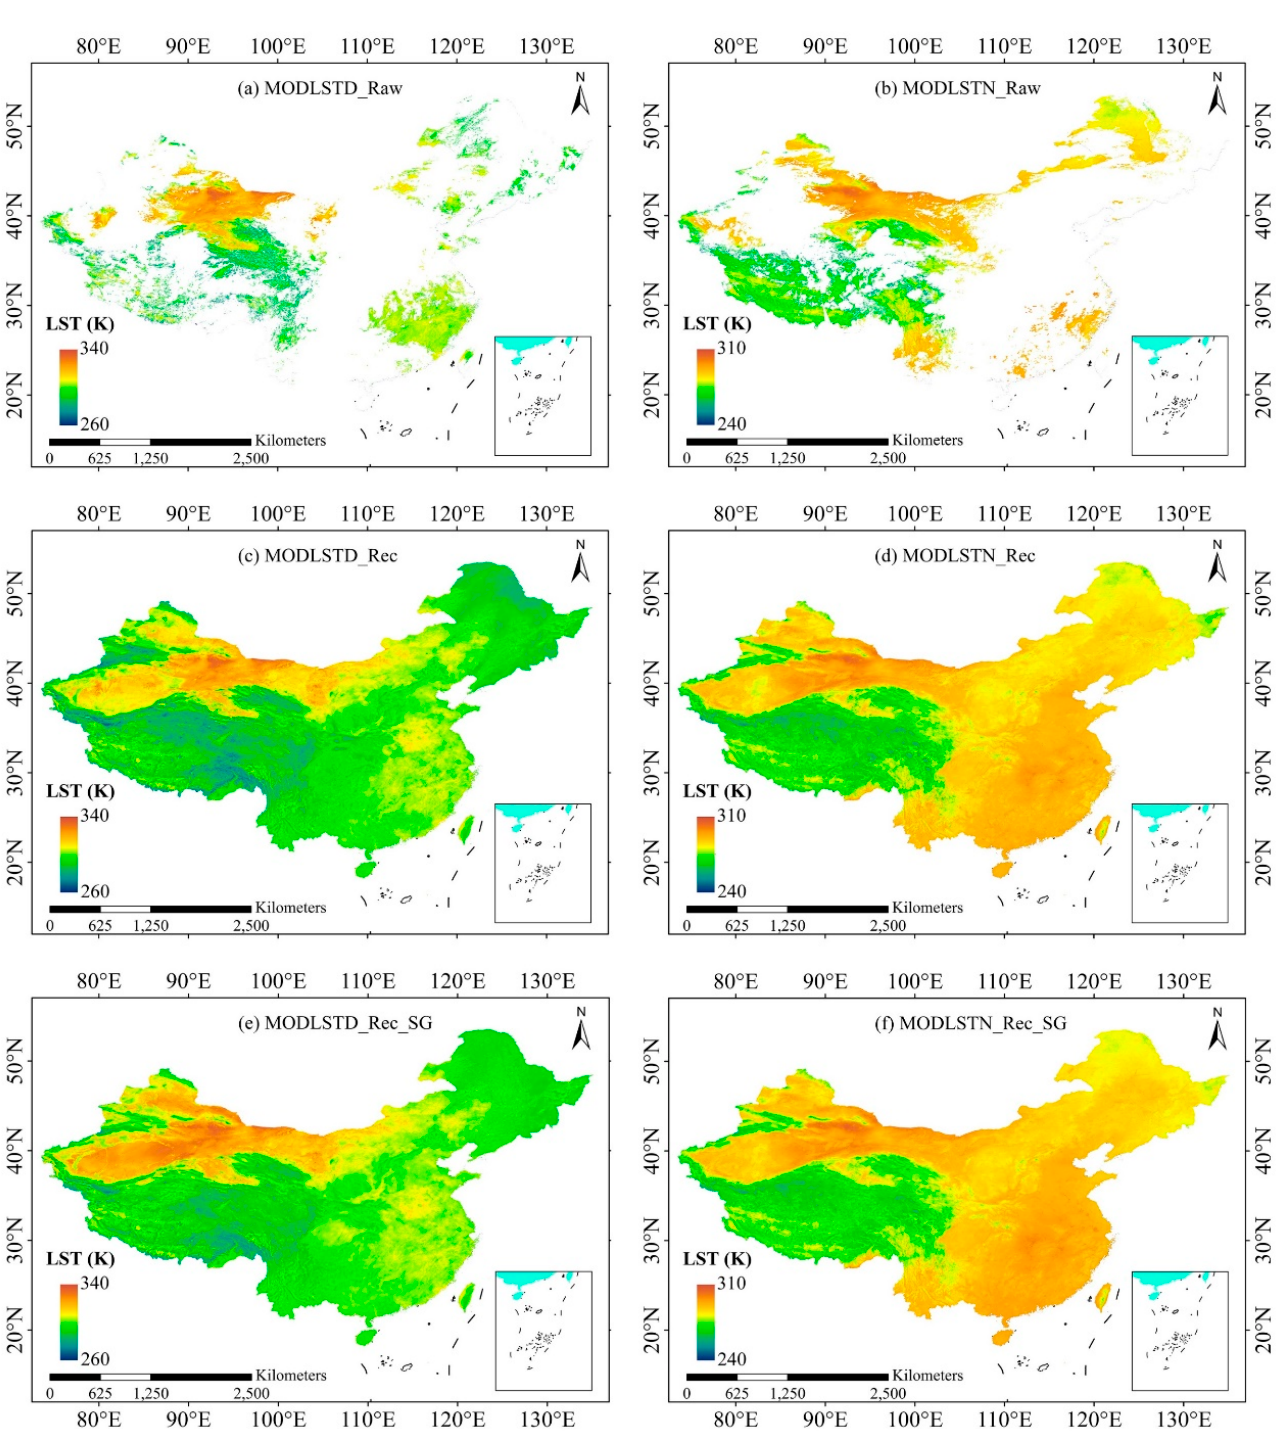
Figure 3. Comparison of ( a ) MODLSTD_Raw; ( b ) MODLSTN_Raw; ( c ) MODLSTD_Rec; ( d ) MODLSTN_Rec; ( e ) MODLSTD_SGRec, and ( f ) MODLSTN_SGRec on the 167th day of 2018.